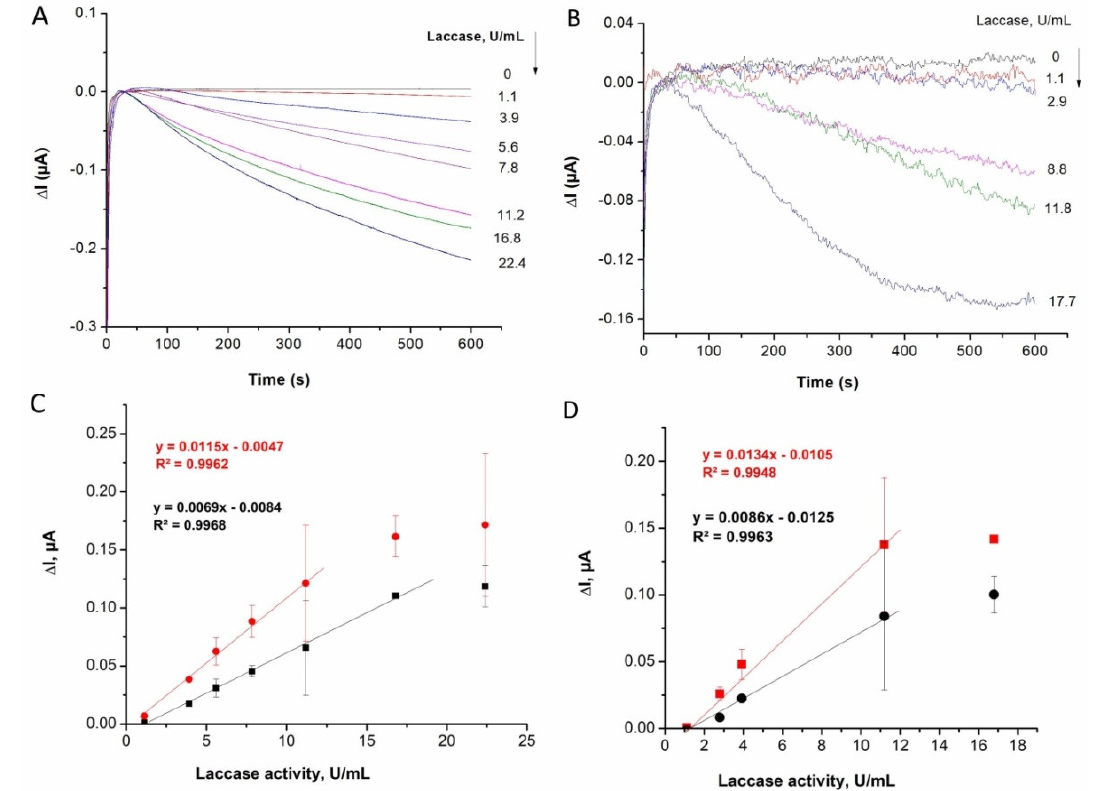
Figure 3. ( A , B ) Current versus time plots obtained using ABTS ( A ) and ABTS–chitosan impregnated paper ( B ) at 0 V vs. Ag/AgCl in the presence of laccase solutions of various activities. ( C , D ) The corresponding calibration plots based on the current changes after 5 min (black) and after 10 min (red), extracted from experiments shown in ( A , B ), respectively.